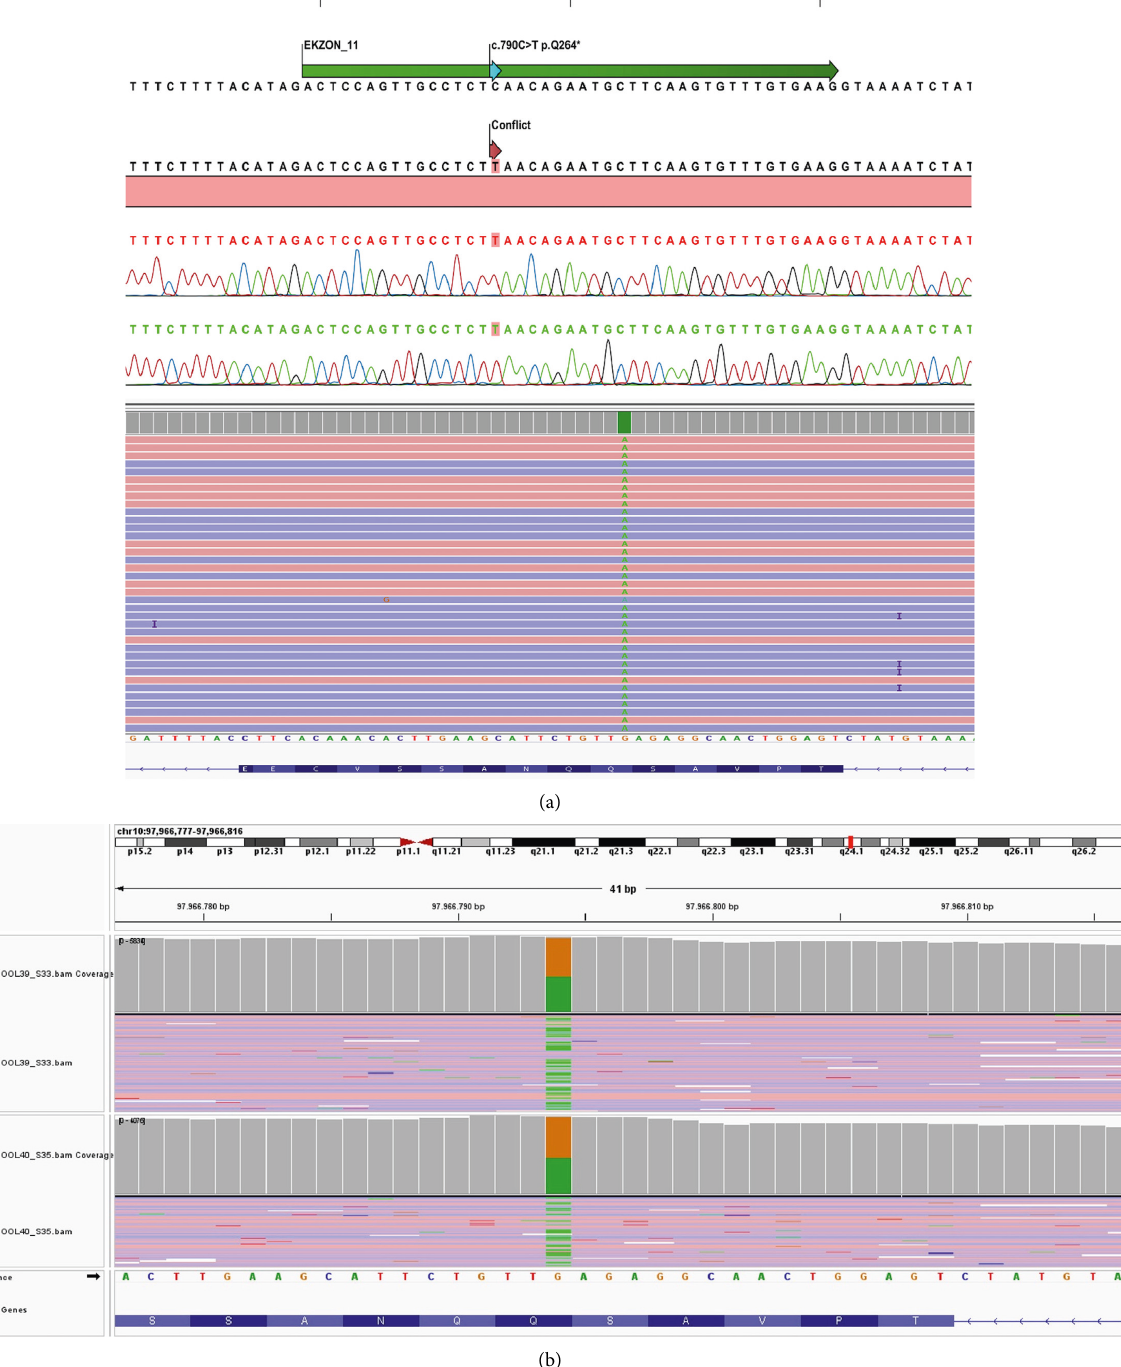
Figure 1: (a) Patient’s BLNK gene sequence analysis images, homozygous c.790 C > T (p.Gln264Ter) mutation in exon 11. (b) His parents’ heterozygous c.790 C > T (p.Gln264Ter) mutation in exon